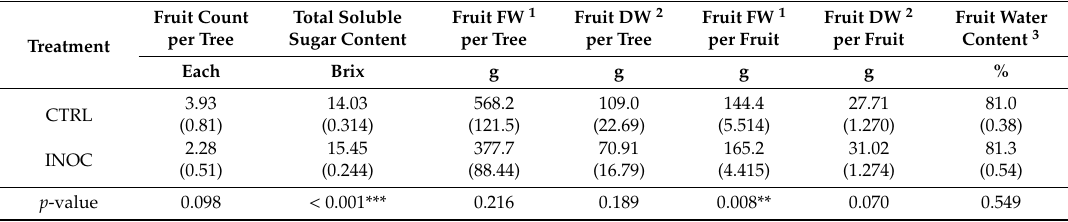
Table 4. Apple fruit characteristics ( n = 59 and 32 for CTRL and INOC, respectively): The means of responses are provided with the standard errors of the means in parentheses (CTRL, mock-inoculated control; INOC, endophyte-inoculated; n = 15). p -values of an unpaired two sample t -test results on each parameter are provided with significance codes of *, **, and *** for < 0.05, 0.01, and 0.001, respectively. Fruit Count per Treatment